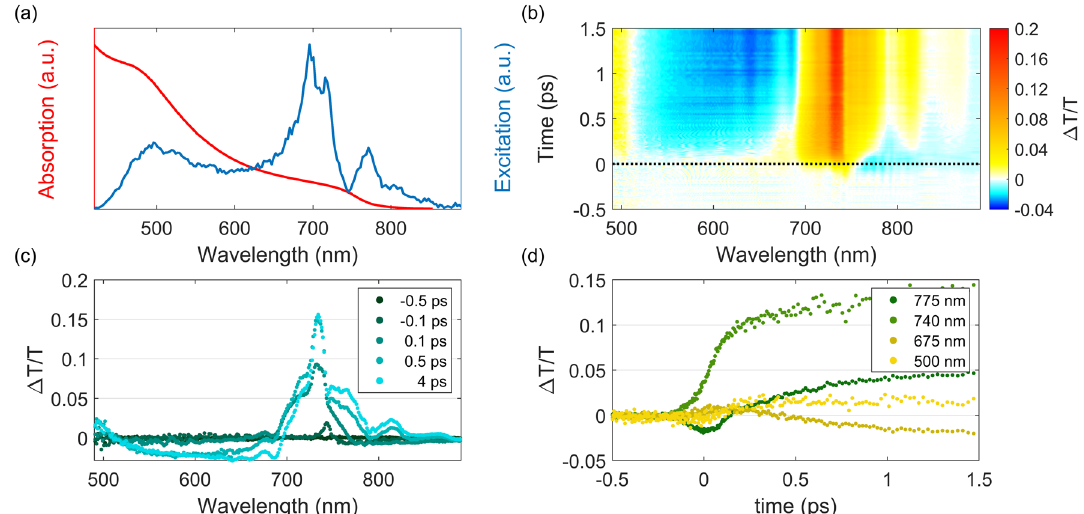
Figure 5. Results from a TAS experiment using 1,000 shot pairs on a spin coated MAPbI 3 Perovskite film under a fluence of 20 μJ/cm 2 . ( a ) The normalized absorption spectrum of the MAPbI 3 sample and normalized excitation spectrum of the pump pulse. The absorption spectrum is adapted from Umari et al. 34 . ( b ) The false color plot of the TAS measurement. ( c ) Spectra at different time delays. Here, a total of 3 sequential time points around the indicated time point are averaged to obtain the time-dependent spectra and ( d ) kinetics at selected wavelengths using a 5 pixel (1.25 nm)